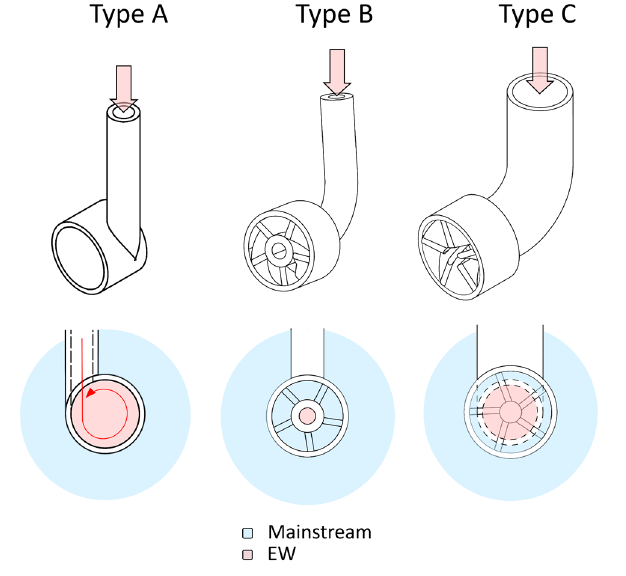
Figure 4. Di ff erent swirler Figure 4. Different swirler configurations.